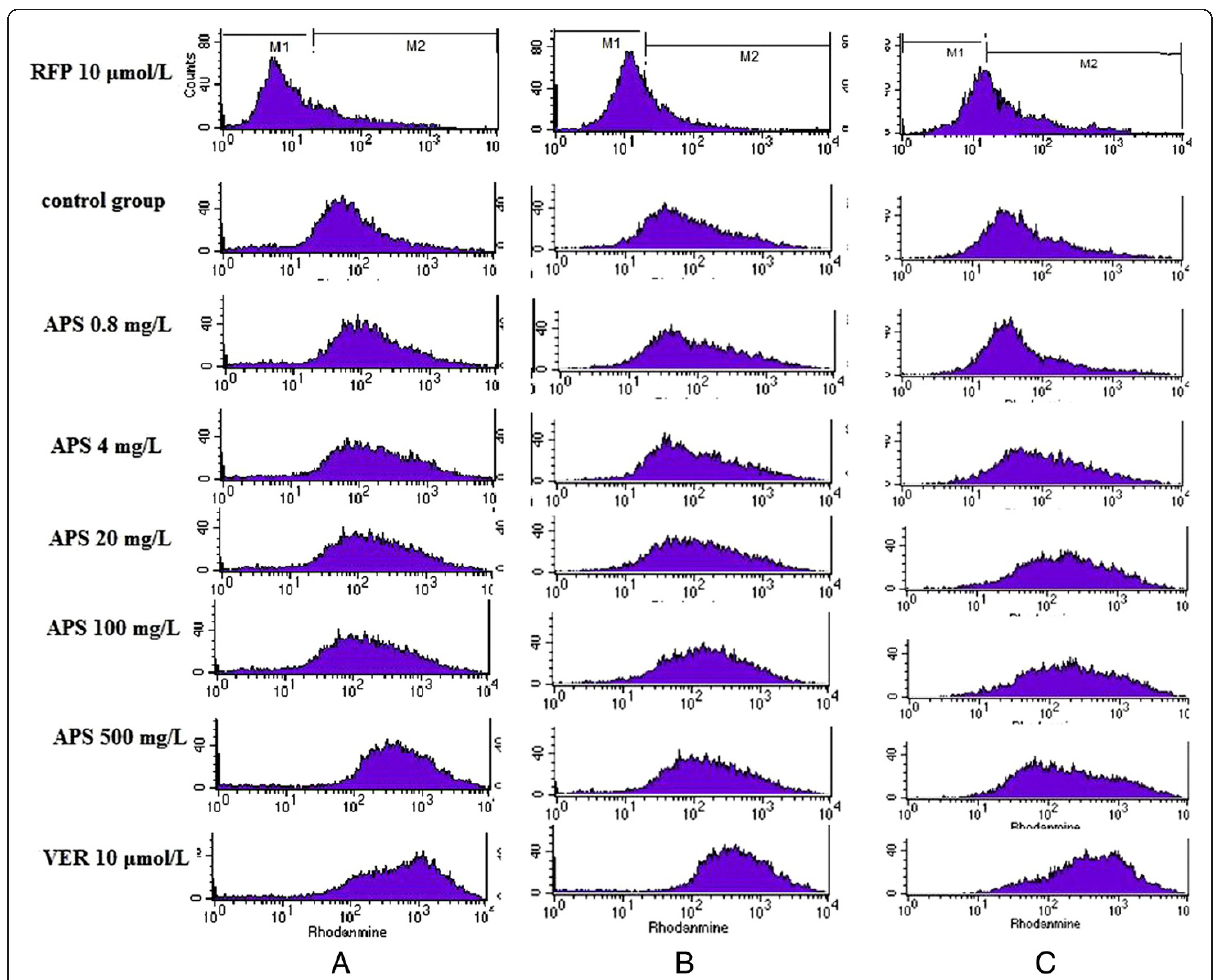
Figure 2 Flow cytometry analysis of P-gp activity with Rh-123 in H22/ADM cells. A: Rh-123 fluorescence intensity curve in H22/ADM cells after exposure to chemotherapeutic agents at 24 h. B : Rh-123 fluorescence intensity curve in H22/ADM cells after exposure to chemotherapy agents at 48 h. C : Rh-123 fluorescence intensity curve in H22/ADM cells after exposure to chemotherapy agents at 72